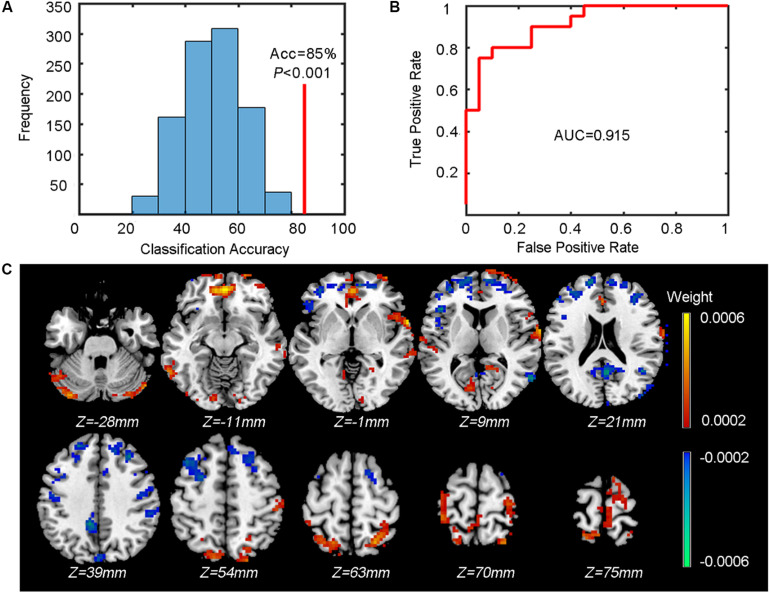
Results of the classification between patients and controls. (A) The classification accuracy (Acc, indicated by the red vertical line) and the P value obtained from the corresponding null distribution generated by 1000 permutations (indicated by the blue bell shape centered around chance level accuracy of 50%). (B) The ROC curve and the corresponding AUC. (C) The weight map (only voxels with the absolute value of weight over 0.0002 are shown). The color of each voxel indicates the weight (cold color indicates negative weights and warm color indicates positive weights).